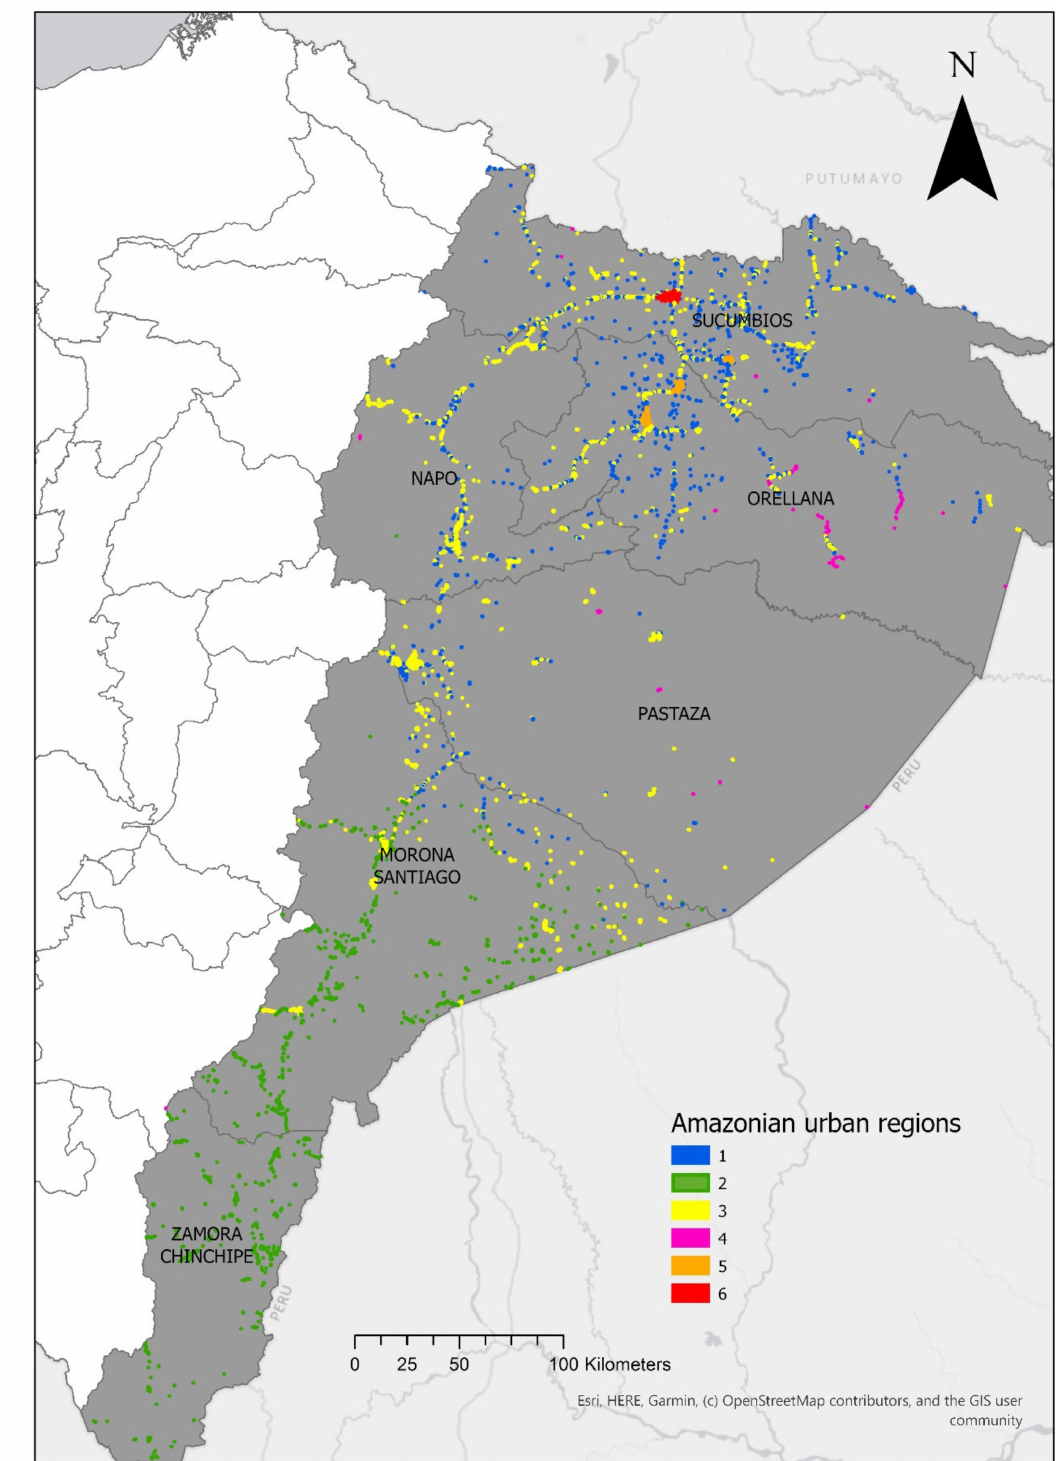
Figure 2. Amazonian urban regions of Ecuador. The outline widths of the urban zones are amplified to better visualize their